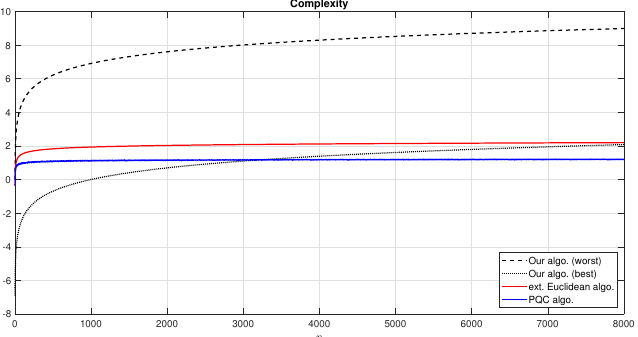
Figure 4. Logarithm of complexity O ( · ) comparison between our algorithm in both a possible worst and better case (i.e., a = 0.001 n and a = 0.999 n , respectively–black dotted lines), the extended Euclidean algorithm (red line) and the post-quantum cryptography (PQC) algorithm (blue